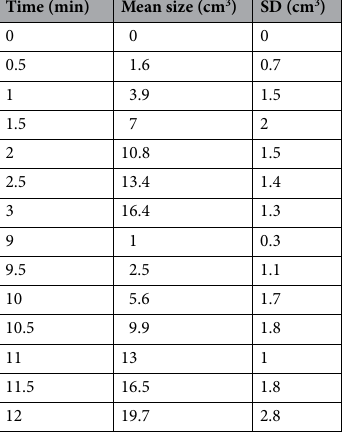
Table 1. Ice formation mean as a function of